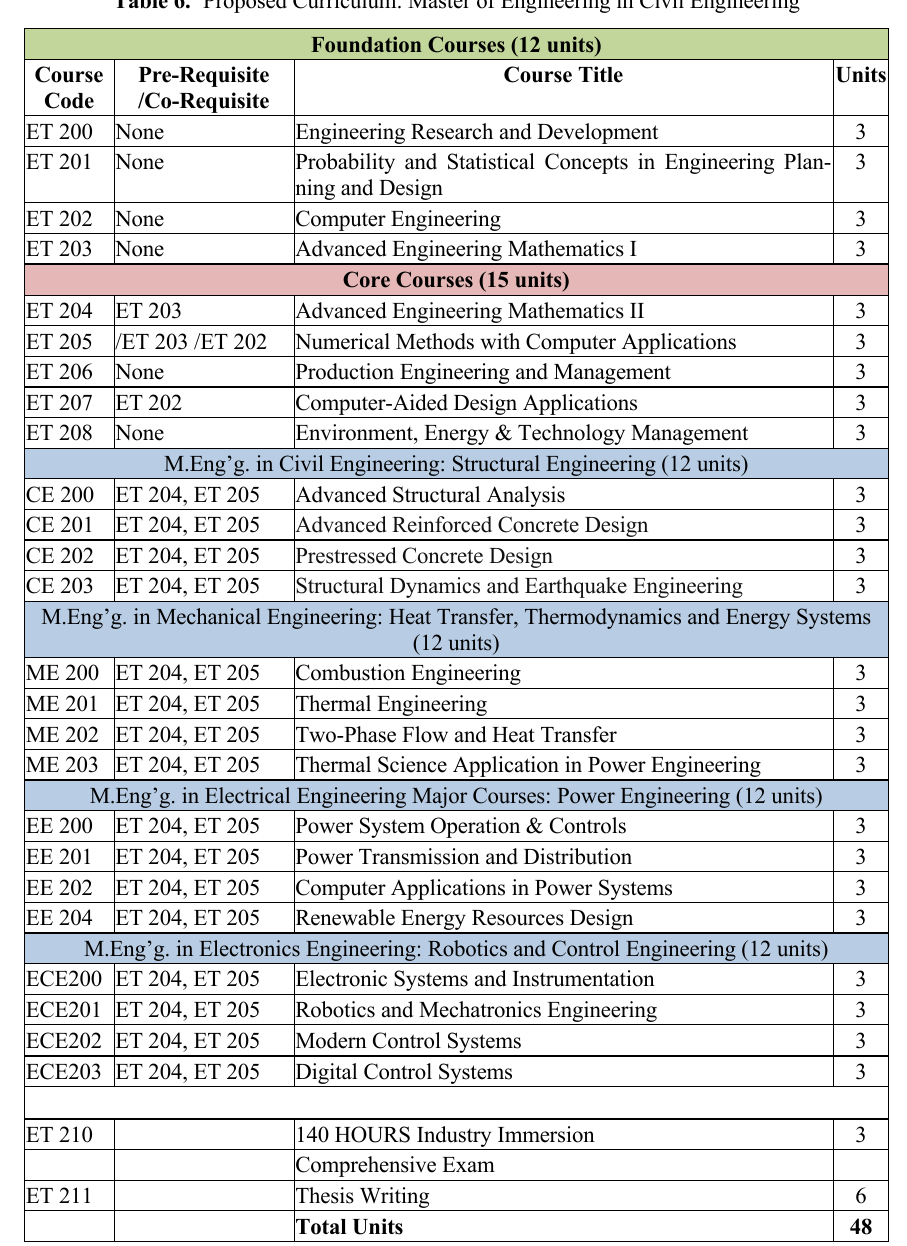
Table 6. Proposed Curriculum: Master of Engineering in Civil Engineering Foundation Courses (12